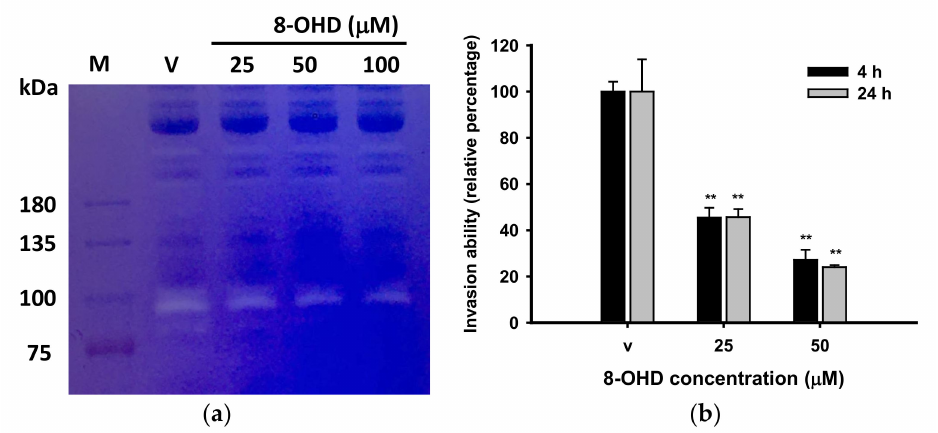
Figure 5. 8-OHD repressed K562 matrix metalloproteinase (MMP) activity and invasion ability. ( a ) Gelatin zymography for the determination of secreted MMP9 activity in K562 cells treated with 8-OHD for 24 h. ( b ) Cell invasion was tested using a modified Boyden chamber assay as described in Section 2. ** p < 0.01 indicates a significant difference compared to vehicle-treated